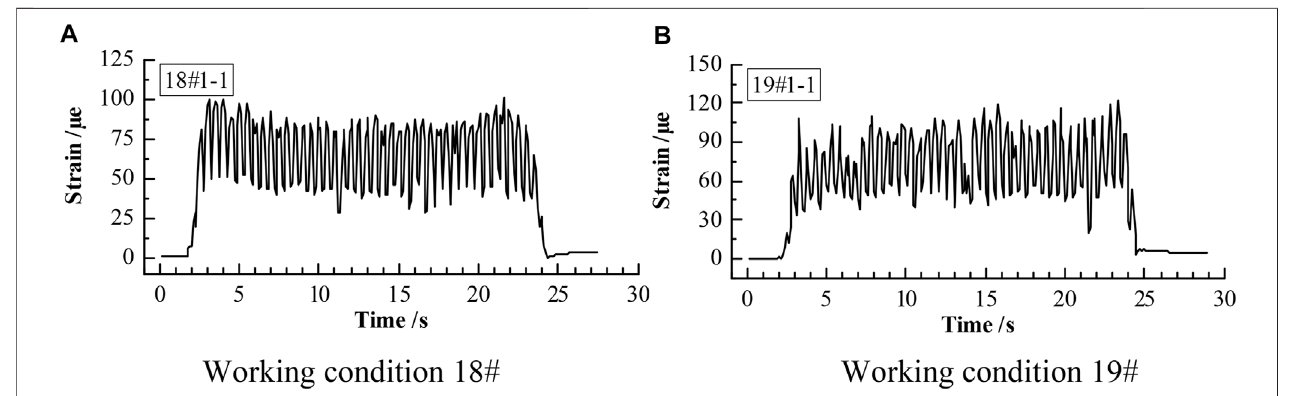
FIGURE 9 | Time history curves of strain of anti-seismic anchor cables in no-slip situation. (A) Working condition 18#. (B) Working condition 19#.